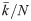
(a) Size of the second largest domain S2 as a function of the average number of neighbors k¯/N for the system defined on a random network. (b) S2 as a function of the number of neighbors k/N for the system defined on a ring with long range interactions. Fixed parameters in both cases are Q = 0.247, B = 0.01, N = 800.